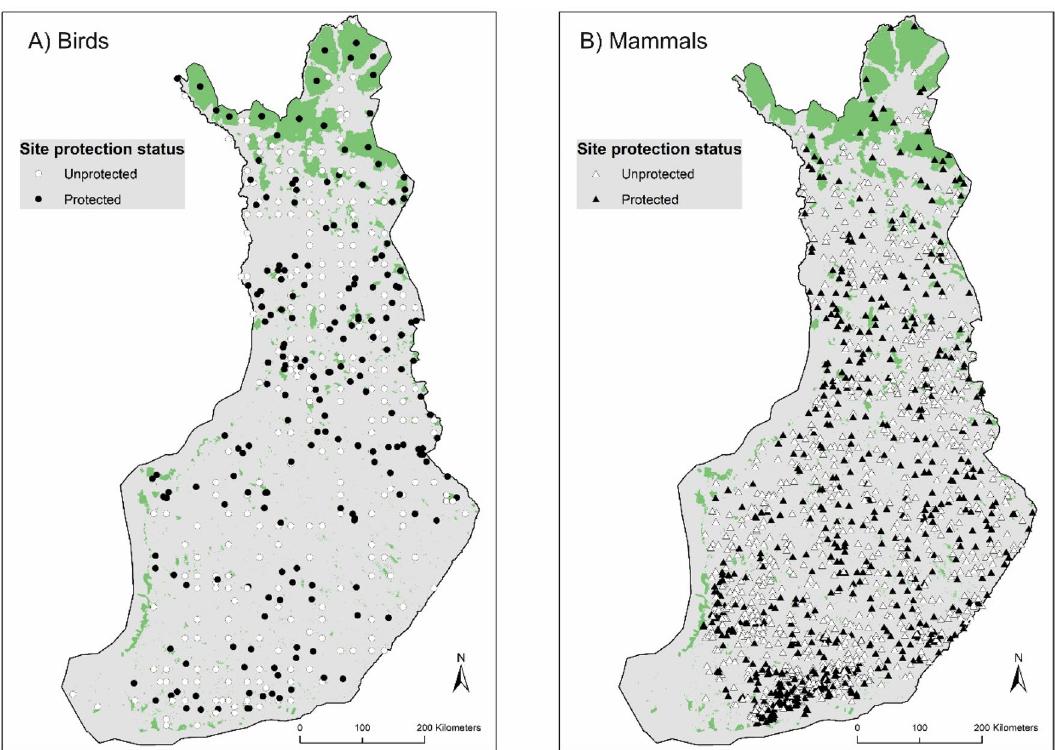
Figure 6. Distribution of the matched protected and unprotected sites for birds (left panel) and mammals (right panel) within Finland, with reference to the protected area network (areas shown in green color) and to the four main vegetation zones: Hemi Boreal (HB), South Boreal (SB), Middle Boreal (MB) and North Boreal (NB). These vegetation zones where used for matching protected sites to similar sites within the same vegetation zone (see “Methods” for more details). Note that many small protected areas are not well visible at this scale. For this reason, some protected sites may appear outside of the protected area network. Maps produced using ArcGIS 10.1 software (©ESRI). The protected area boundaries shown are derived from the open access resource at www. prote ctedp lanet. of dimensionality” problem discussed in Ref. 51 ). Because of this dimensionality problem, and also because we are interested in comparing the intra-specific niche within and outside of PAs, we ignored environmental vari- ables other than land use. Such variables (e.g. climatic conditions) are likely spatially autocorrelated at scale of this study. This is because we matched protected with unprotected sites within the same vegetation zone, which also captures rather homogeneous bioclimatic conditions. Therefore, including these other dimensions would represent a very high cost in terms of niche model stability and result reliability, compared to likely marginal gain given the focus of this study. We derived the proportion of the coverage of each of the above seven land use classes within a 500 m buffer area around each bird line transect outside protected areas. Because the bird line transects inside protected areas were available only as pooled observations for each protected area and year, we used a circular buffer centered at the centroid point of each protected area to derive the proportion coverage of the seven land use classes. The radius of this circular buffer was 1331 m, which represents an area equal to the average area covered by buffers around unprotected surveys. While this area may be larger than that of the small protected areas considered in this study, such larger area may be still ecologically influenced by the presence of the protected areas via spillover mechanisms 52 . We however also extracted the cover of each of the seven habitat classes from across the entire area of the protected area. The correlation between the habitat cover as extracted using the radius, or using the entire protected area, was high for most of the variables (see Supplementary Fig. S1), indicating that this choice would have little influence on the final results. Based on these correlation results, and on the rationale given above, we therefore opted to use the habitat variables as extracted using the radius approach for bird surveys inside protected areas, because this would enhance the consistency and compa- rability in the area amount and its shape between protected and unprotected sites for the birds. For the mammal surveys, we used a buffer centered at the centroid of the triangle survey and with radius of 2809 m, which depicts the area of the circle crossing the three vertices of the triangle and an extended 500 m beyond that. The habitat surrounding the transect is hence measured at different scales for birds and mammals, which however, does not undermine the analysis of differences in ecological niche between and within species belonging to either taxo- nomic group (birds or mammals). Moreover, each survey route was also assigned a status whether it was protected or unprotected. For the bird data, this information was already available because these data have been collated from two separate databases,